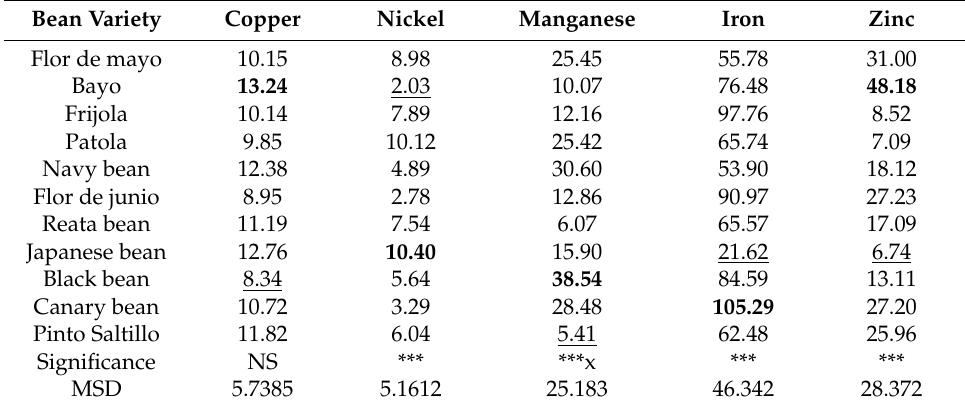
Table 5. Concentration of micronutrients (mg/kg) found in bean varieties grown and consumed in the state of Zacatecas,